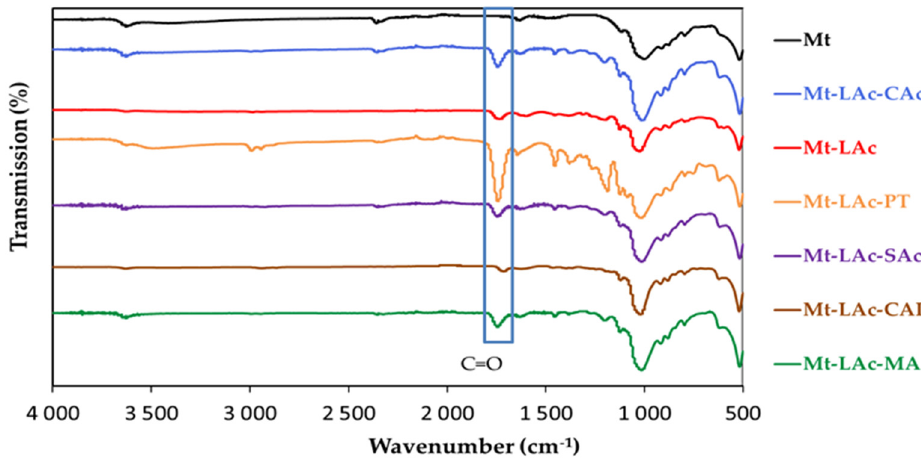
Figure 1. FTIR spectra for Mt and organophilic montmorillonites.